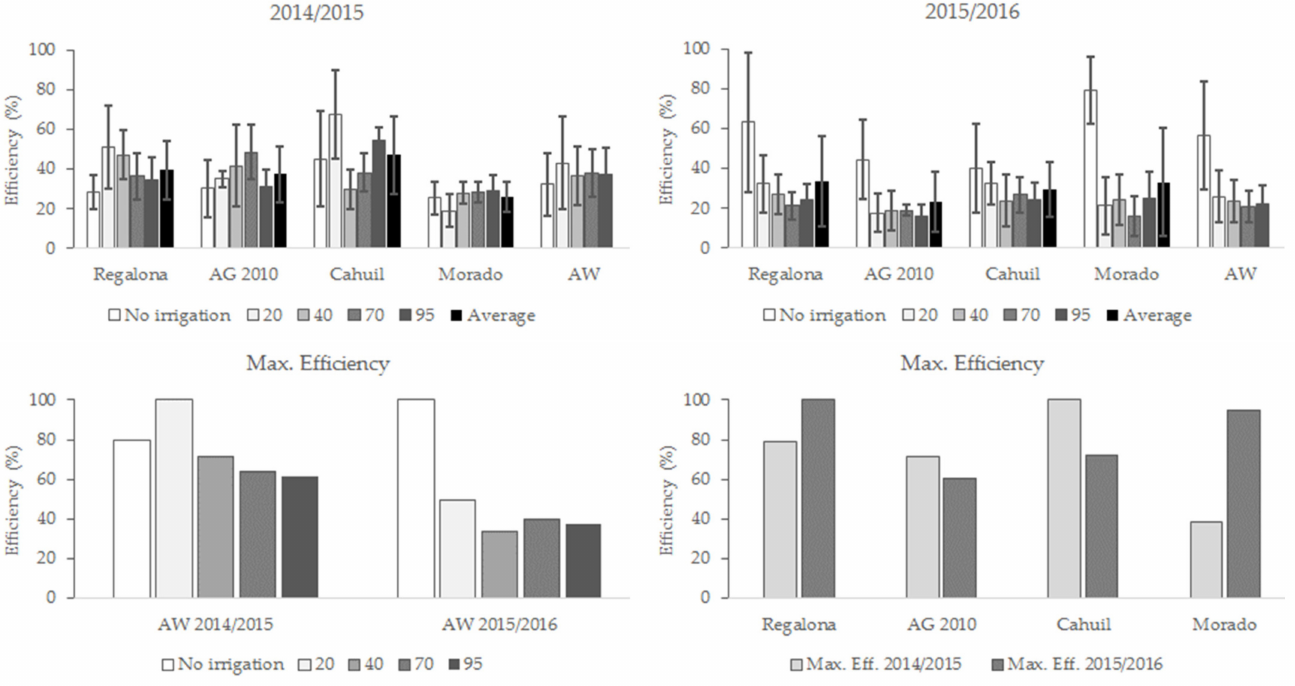
Figure 6. Average technical efficiency in albumin production in quinoa genotypes subjected to different water deficit conditions in the 2014/2015 and 2015/2016